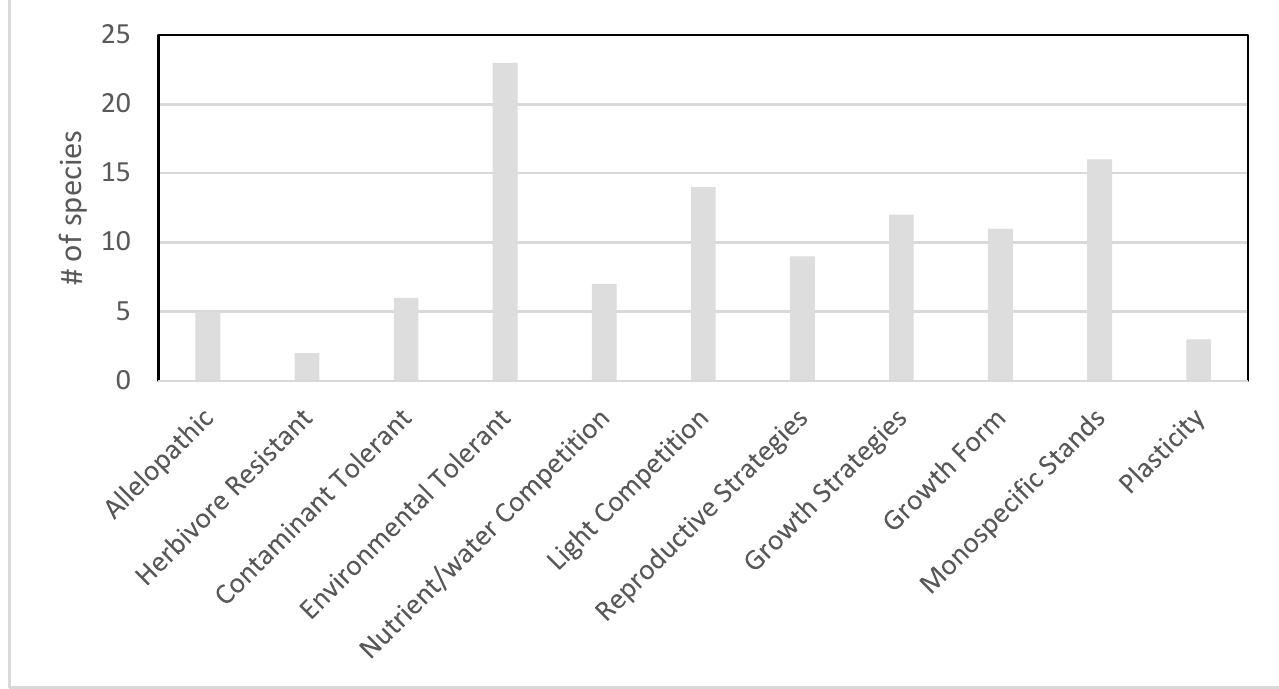
Figure 4. Adaptations identified as assisting in competition (n = 55; however, species can have multiple adaptations). Species scoring “unknown” or “low impact” typically also have adaptations noted and are included in this